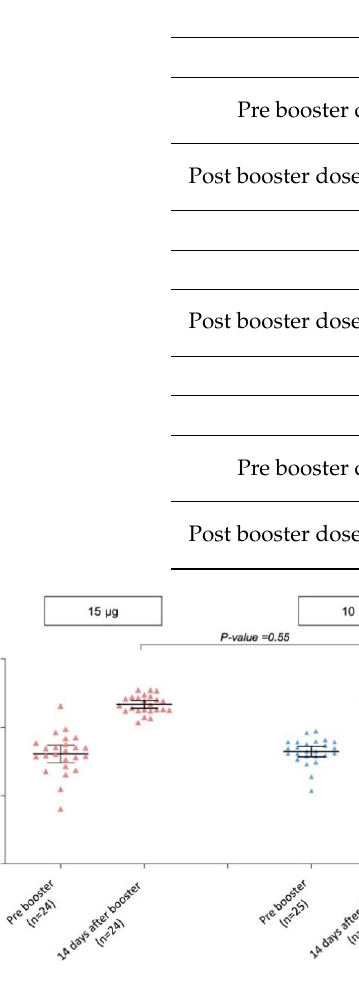
Table 2. Humoral immune response after BNT162b2 booster in healthy adolescents by booster groups.